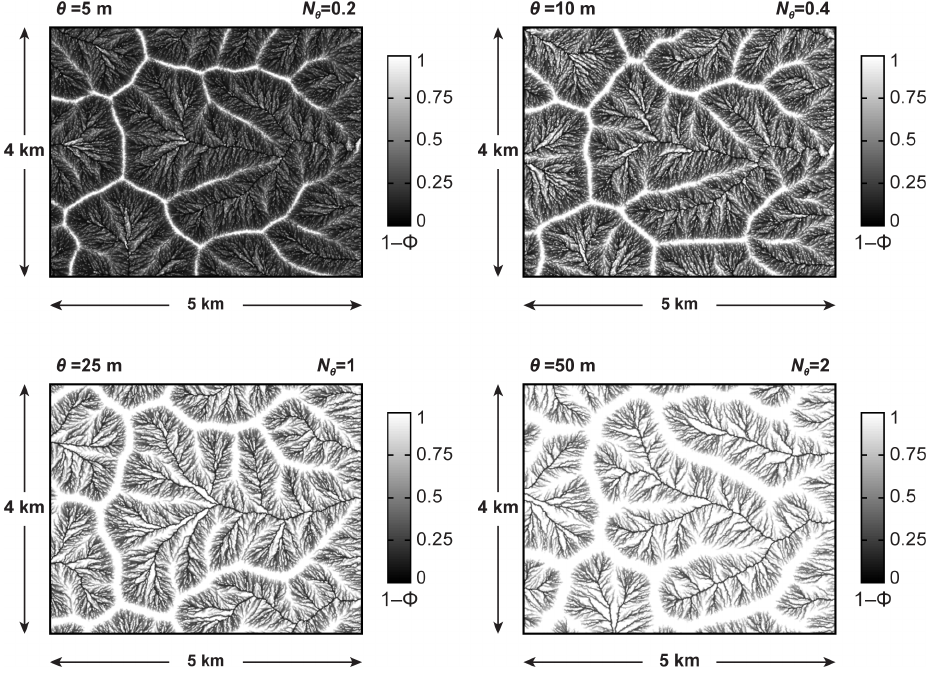
Figure 7. Control of the incision-threshold number N θ on the spatial distribution of the fractional reduction in incision rate. We map the quantity 1 − (cid:56) across four steady-state simulated landscapes with different values of N θ . We use the same values of N θ as in Fig. 6. Details about the setup and parameters of these simulations are presented in Appendix B. Lighter colors correspond to larger values of 1 − (cid:56) , i.e., to stronger influence of the incision threshold. The spatial distribution of 1 − (cid:56) follows the dendritic pattern of the valley network. As N θ increases, the maps become lighter; i.e., areas with a strong influence of the incision threshold become more widespread both on hillslopes and in